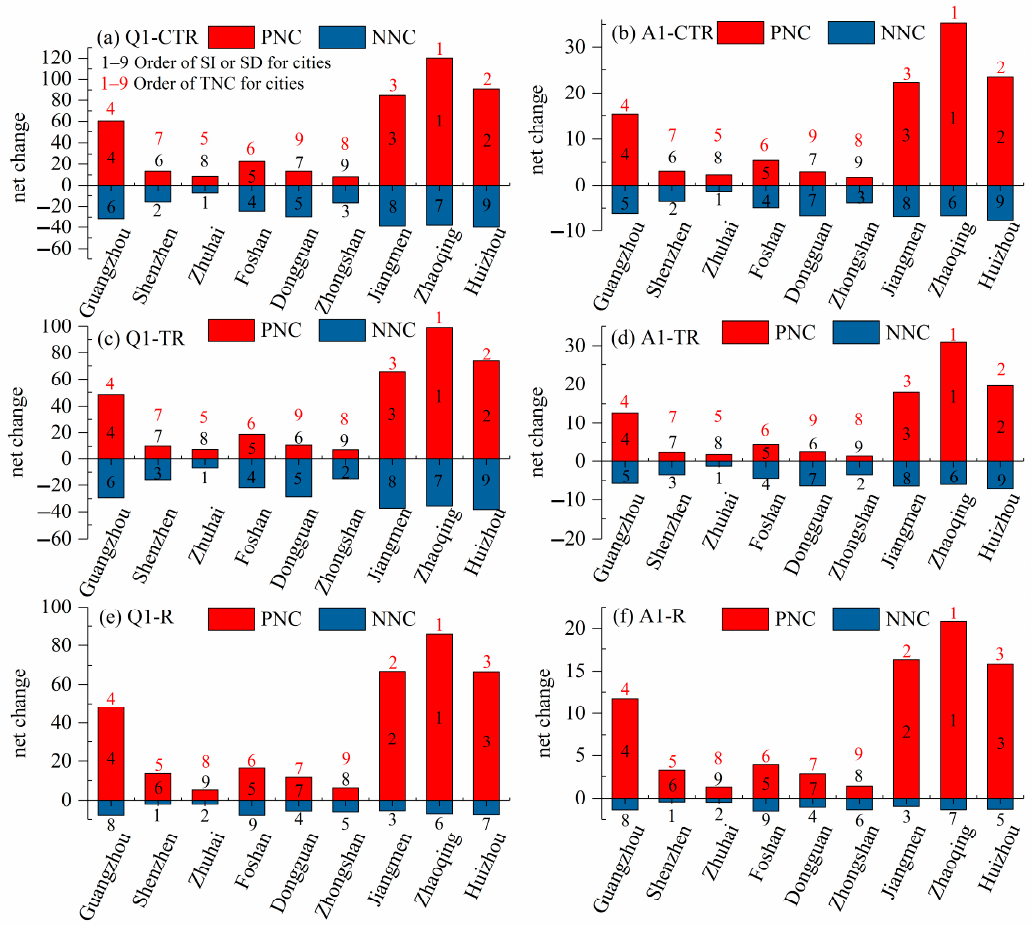
Figure 12. Comparison of net change of Q1-CTR, A1-CTR, Q1-TR, A1-TR, Q1-R and A1-R: ( a ) city-scale vegetation net change detected by Q1-CTR; ( b ) city-scale vegetation net change detected by A1-CTR; ( c ) city-scale vegetation net change detected by Q1-TR; ( d ) city-scale vegetation net change detected by A1-TR; ( e ) city-scale vegetation change detected by Q1-R; and ( f ) city-scale vegetation change detected by A1-R.